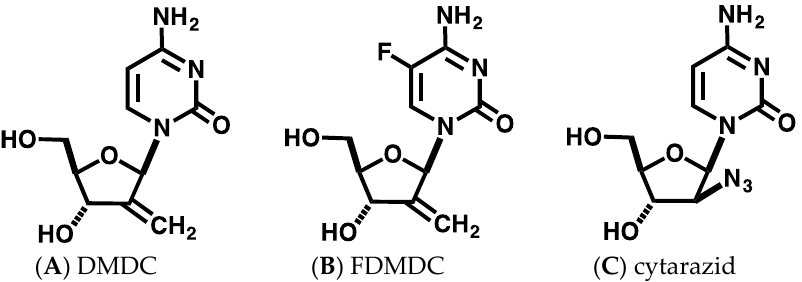
Figure 1. Chemical structure of nucleosides used in this study. Structures of DMDC ( A ), FDMDC ( B ), and cytarazid ( C ) are shown.